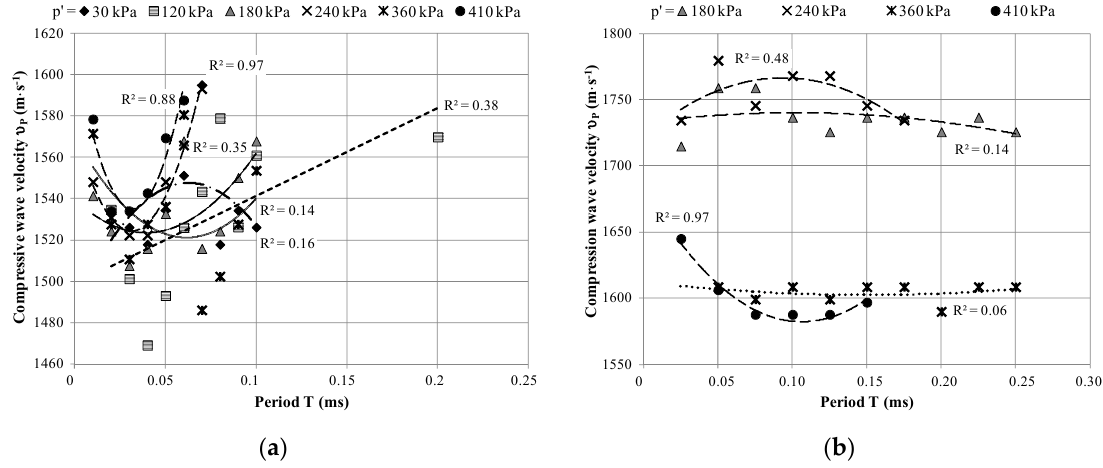
Figure 10. Variation of measured υ P with period. ( a ) Peak-to-peak method; ( b ) start-to-start method.